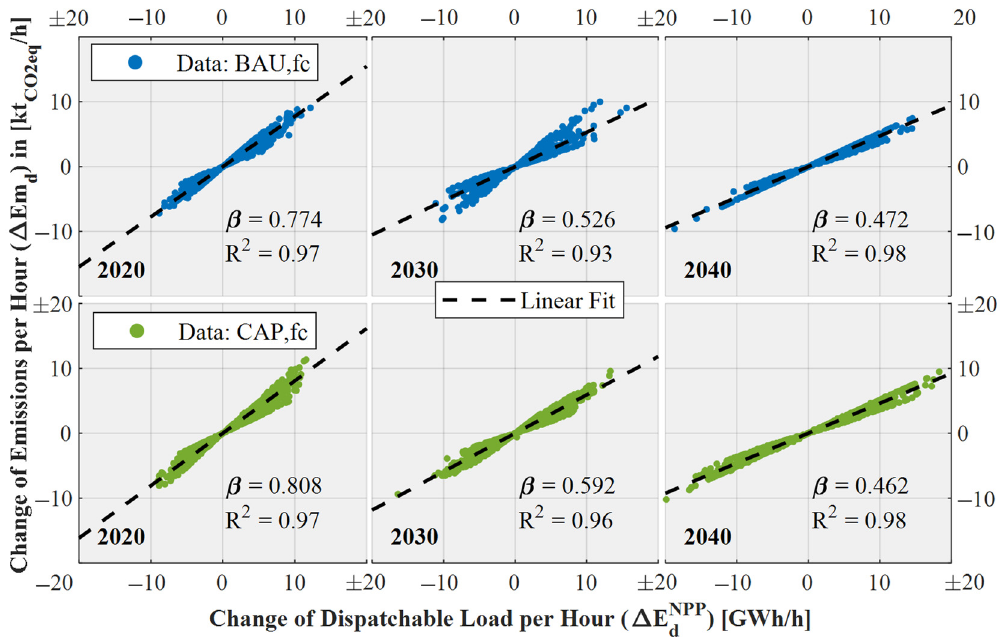
Figure 8. Change in GHG emissions from the domestic, conventional, dispatchable power plants ∆ Em d , t over the change in domestic, conventional, dispatchable power production ∆ E NPP from the BAU and CAP scenarios for three selected milestone years. The marginal emission factor according to the linear regression method is given as the gradient β , with the associated coefficient of determination R 2 . Model results.